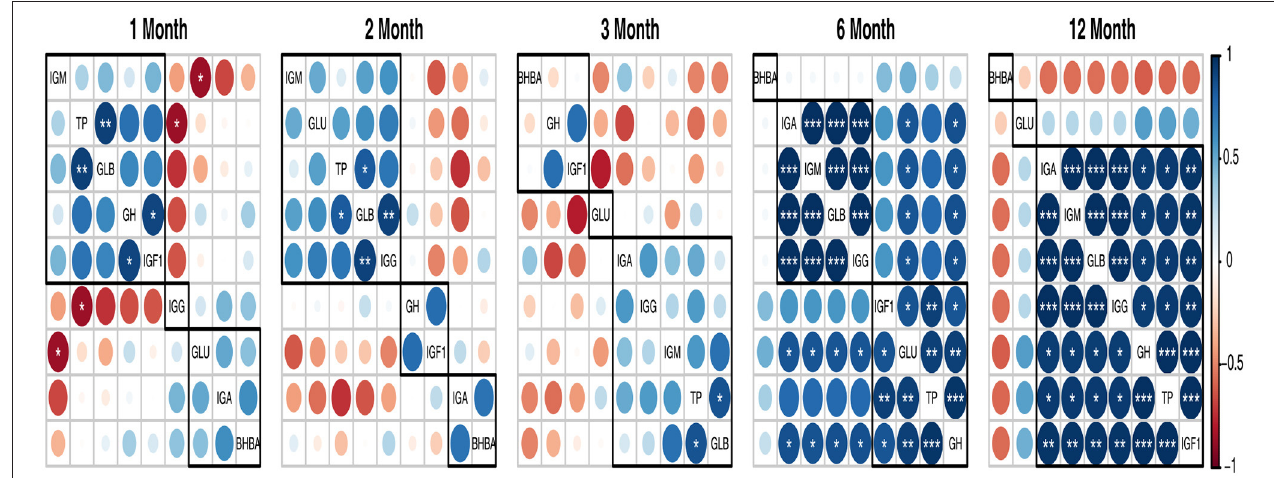
FIGURE 1 | A heatmap illustrating Pearson’s correlation coefficients between blood parameters in goats from 1 to 12 months of age. Significance levels: * p < 0.05, ** p < 0.01, and *** p <